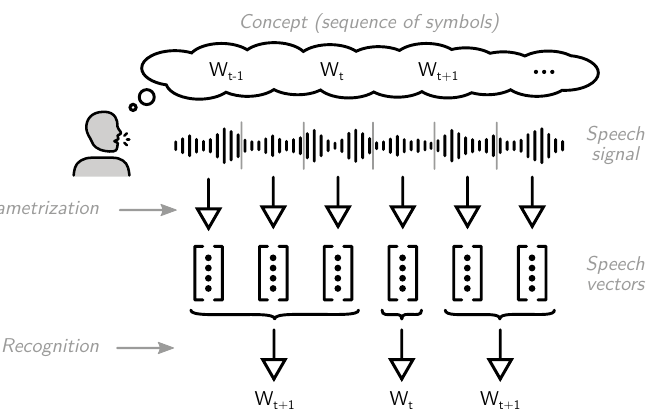
Figure 6. The causal assumptions built into HMM-style models made explicit, as illustrated in the HTK book (reproduced from Young et al.